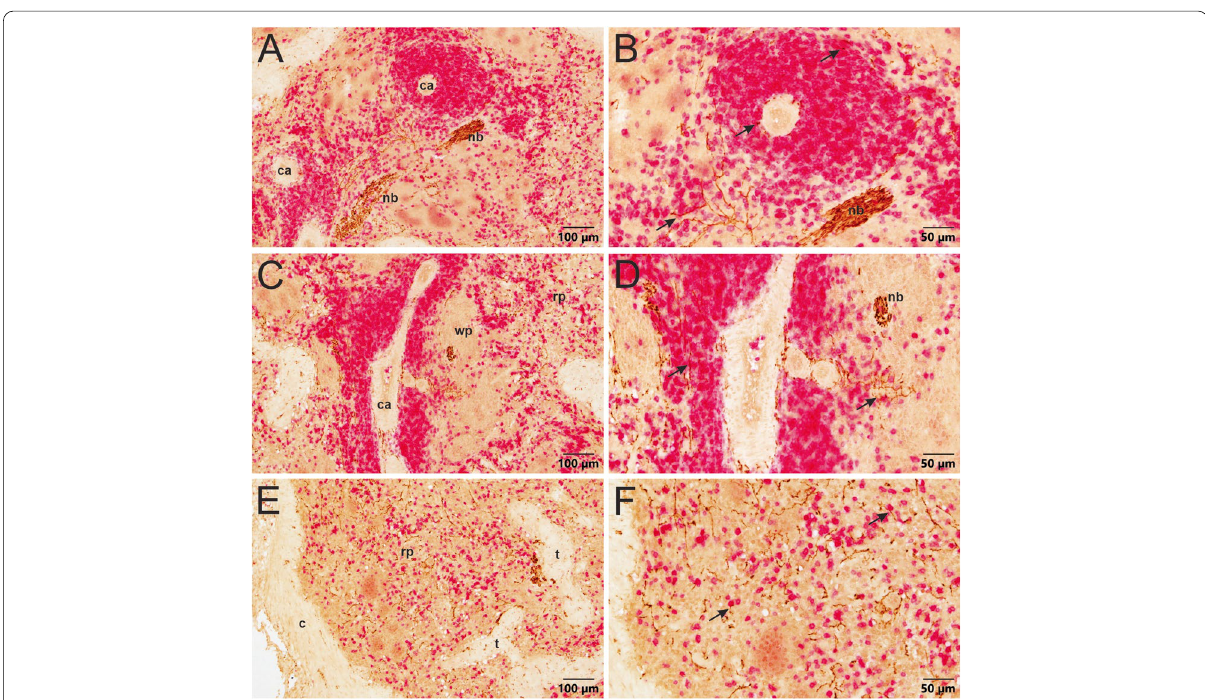
Fig. 9 Double-labeling IHC in porcine spleen tissue for TH (brown) and CD3 (red). A CD3 T leukocytes are densely packed around central + arterioles (ca.). TH nerves extend from the nerve bundles (nb) into the surrounding parenchyma. B Higher magnification image of panel A + showing the close association of TH nerves and CD3 T leukocytes both around the central arteriole and in the surrounding parenchyma, + + indicated by arrows. C TH nerves and CD3 T leukocytes are tightly packed around the central artery (ca.) and loosely packed throughout the red + + pulp (rp). D Higher magnification image of panel C showing the close association of TH nerves with CD3 T leukocytes around the central artery, + + indicated by arrows. Note the nerve bundle in the top right corner. E The capsule, and trabeculae of pig spleens have less innervation. However, the red pulp is rich with sympathetic innervation and leukocytes. F Higher magnification image of panel E, showing the close apposition of TH nerves + and CD3 T cells in the red pulp beneath the capsule in pig spleens, indicated by +